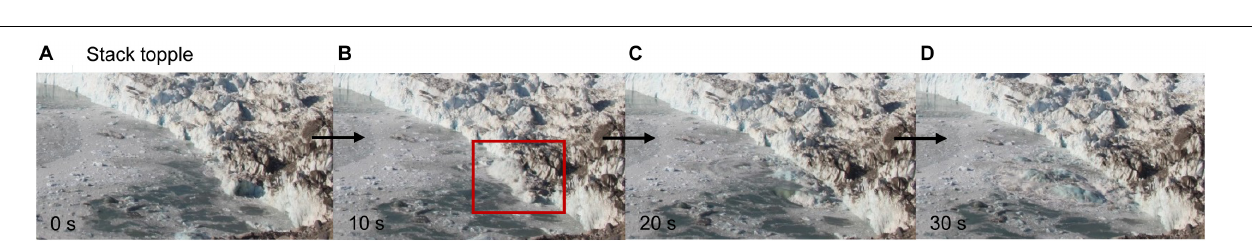
FIGURE 4 | An example illustrating the definition of a magnitude 4 calving event for the sTLC images on 8 July 2018. The image sequence shows the example over time from 0 s (A) to 10 s (B) and 20 s (C) . Examples of magnitude 1–3 are shown in Supplementary Figure 2 .